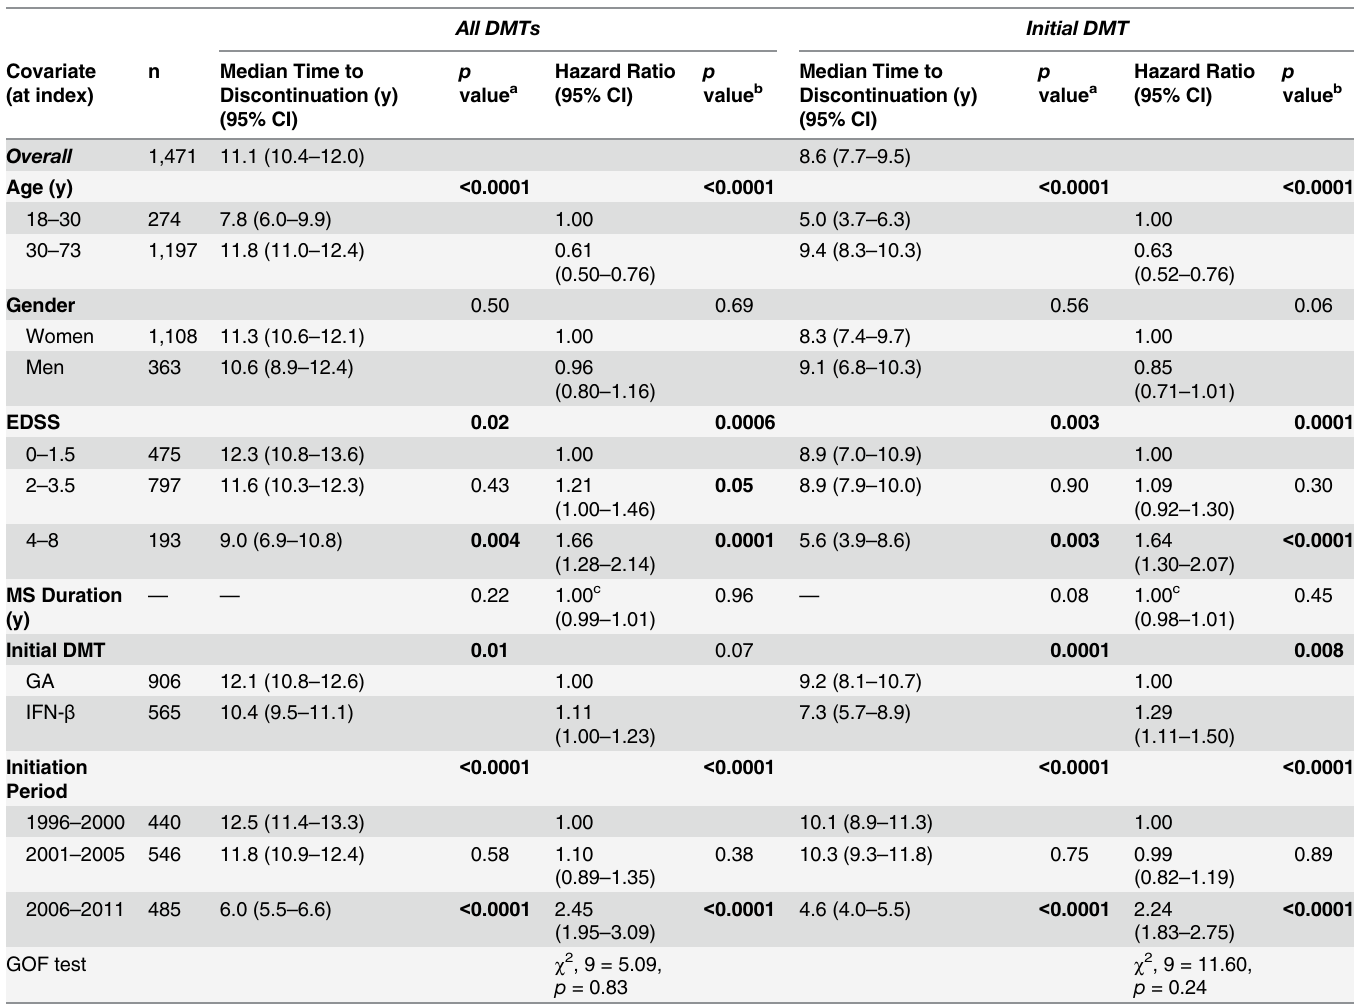
Table 2. Kaplan-Meier and multivariable Cox regression analysis of potential factors associated with time-to-discontinuation of all first-line DMTs and the initial DMT prescribed. All DMTs Initial